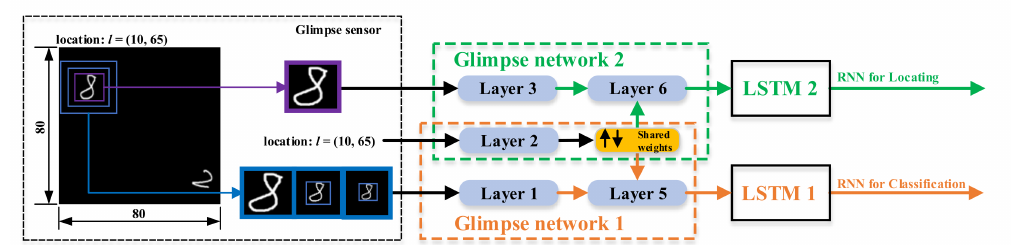
Figure 10. GARN overview. The proposed GARN model consists of two RNNs: one for locating ROIs, and the other for classification.